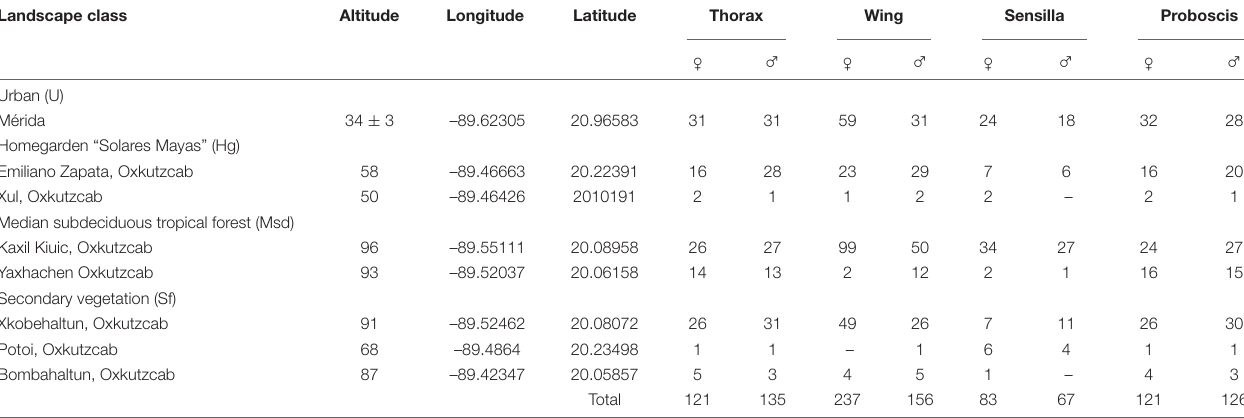
TABLE 1 | Number of specimens of Triatoma dimidiata according to measured traits per landscape class. Landscape class Altitude Longitude Latitude Thorax